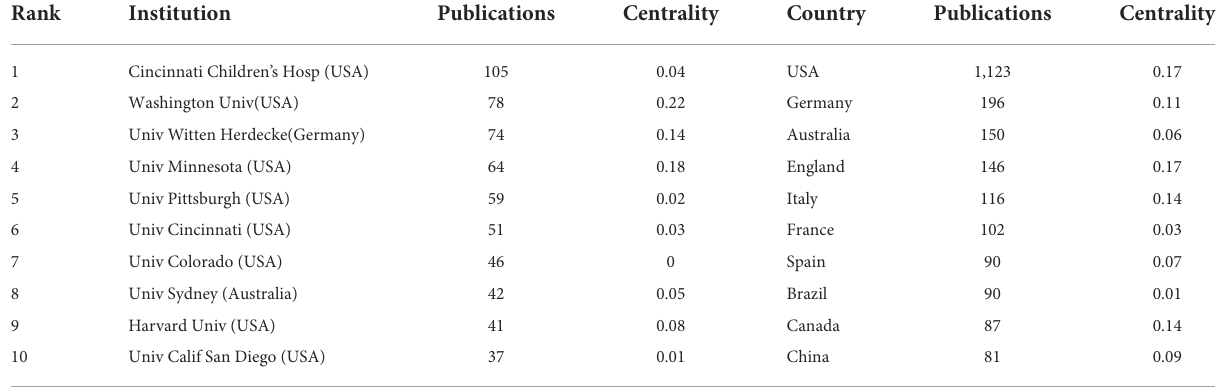
TABLE 1 Top 10 contributing institutions by countries/regions and centrality.